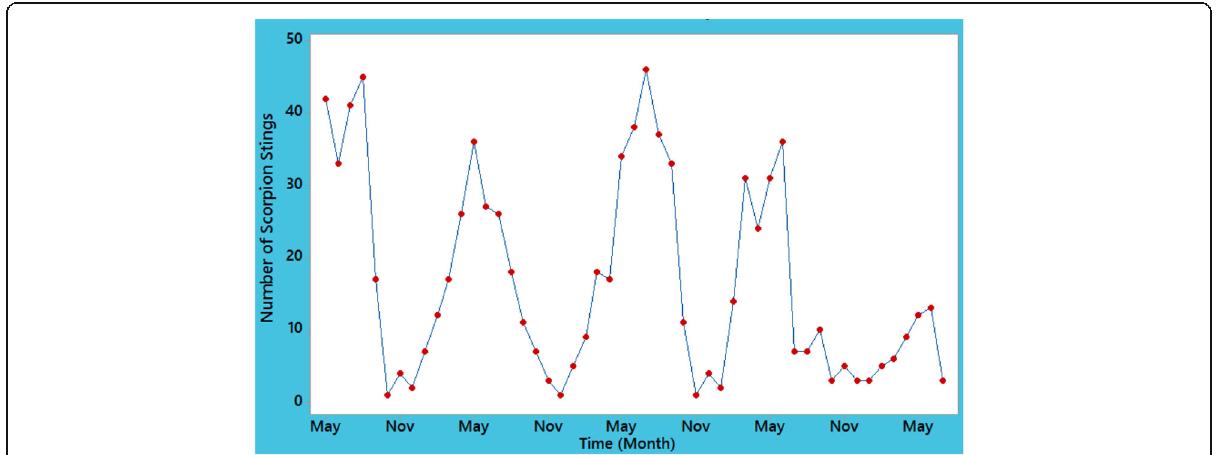
Fig. 5 Time series curve of scorpion sting cases from May 2012 to July 2016